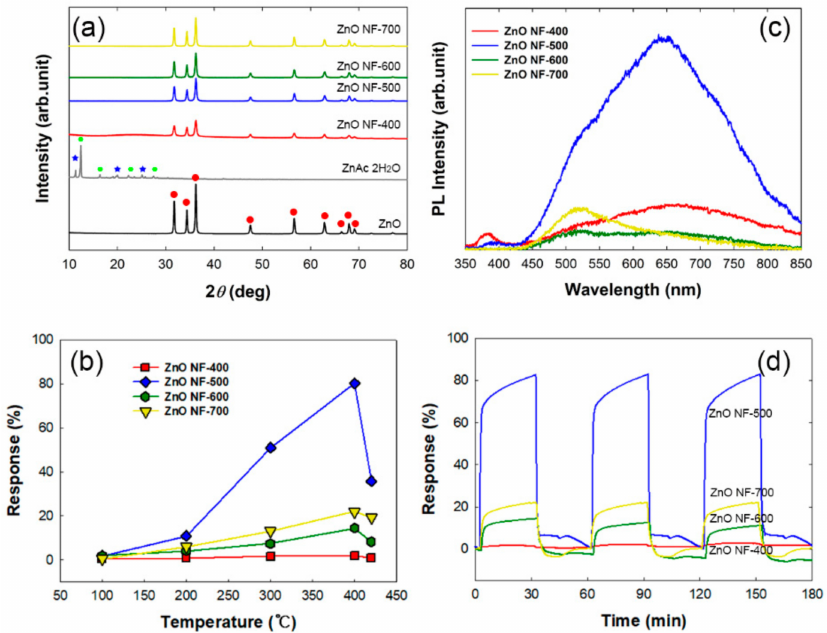
Figure 3. ( a ) X-ray di ff raction (XRD) spectra of as-prepared ZnO nanofibers with di ff erent